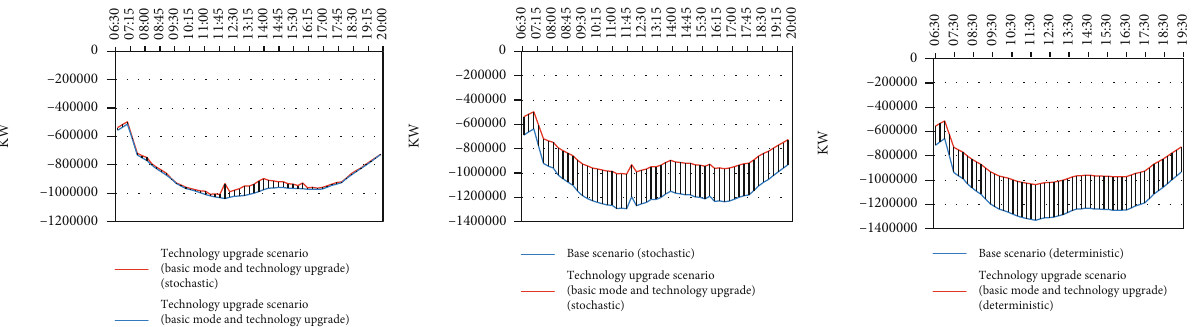
Figure 23: Di ff erent modes in the technology upgrade scenario (day).